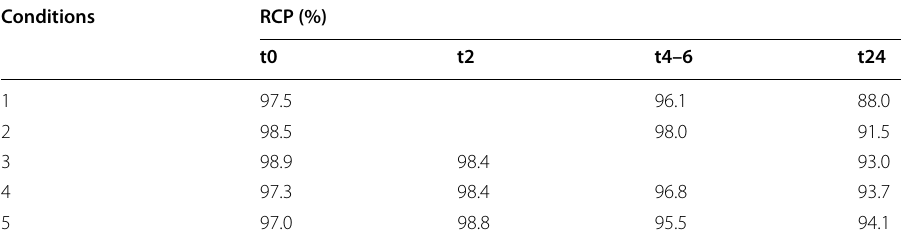
Table 4 RCP results of different labelling conditions (74 MBq) for optimization as measured by HPLC (after t 0, 2, 4–6, and 24 h) = Conditions